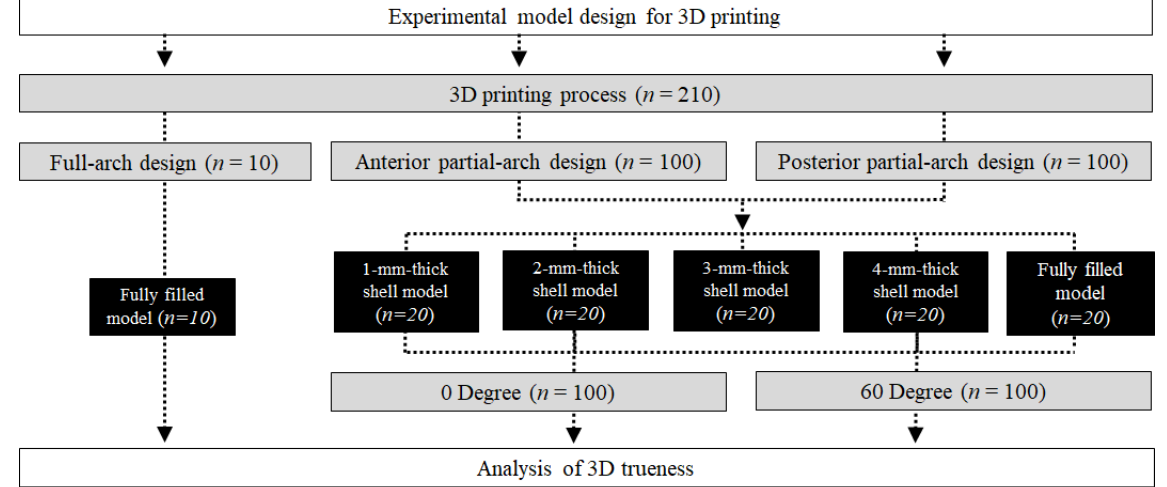
Figure 1. Flow chart of the study design.